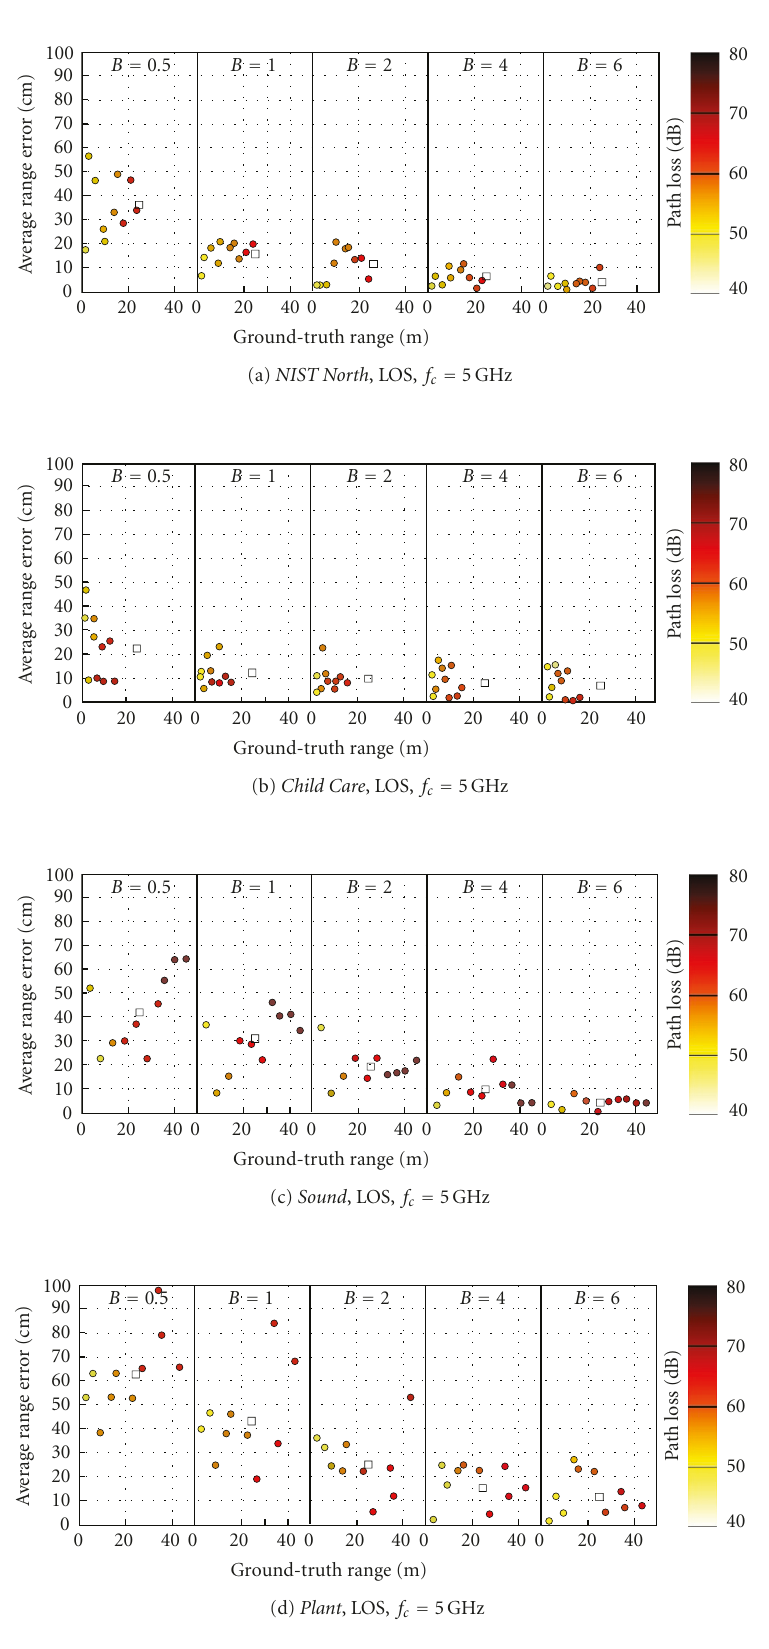
Figure 5: Range error (cm) versus ground-truth range (m) while varying bandwidth B (GHz) in line-of-sight